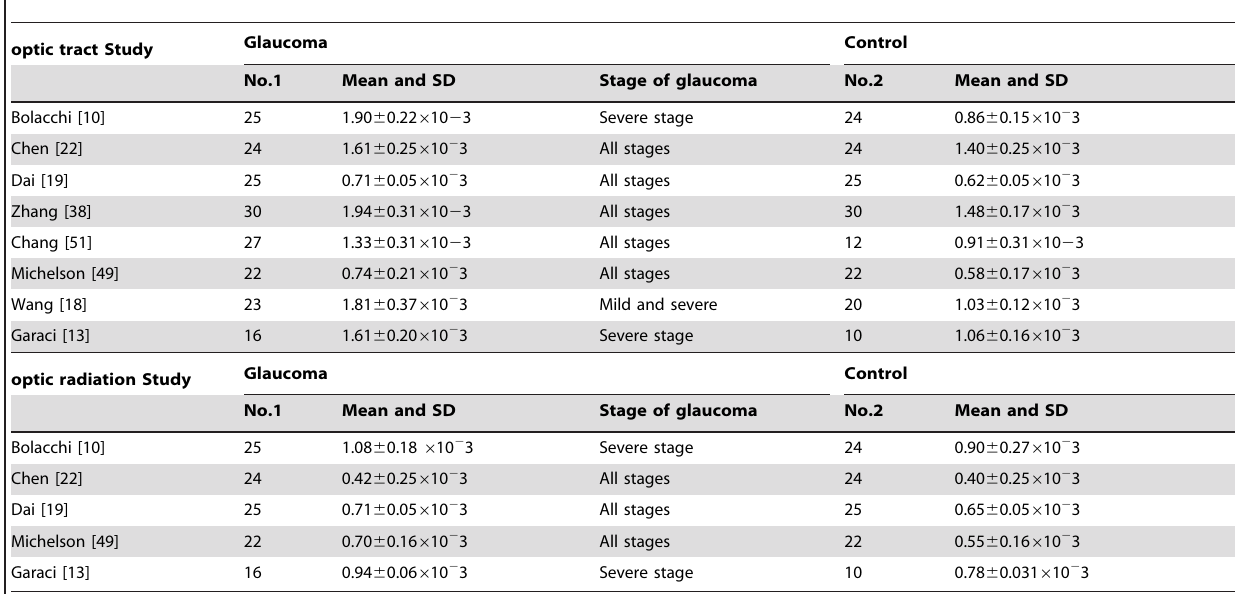
Table 3. Mean diffusivity (mean and standard deviation) in the optic tract (top) and optic radiation (bottom).